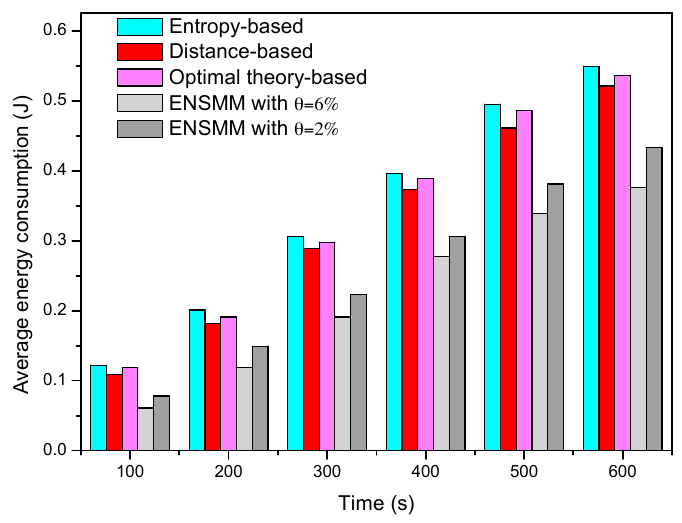
Figure 12. The average energy consumption in tracking stage.